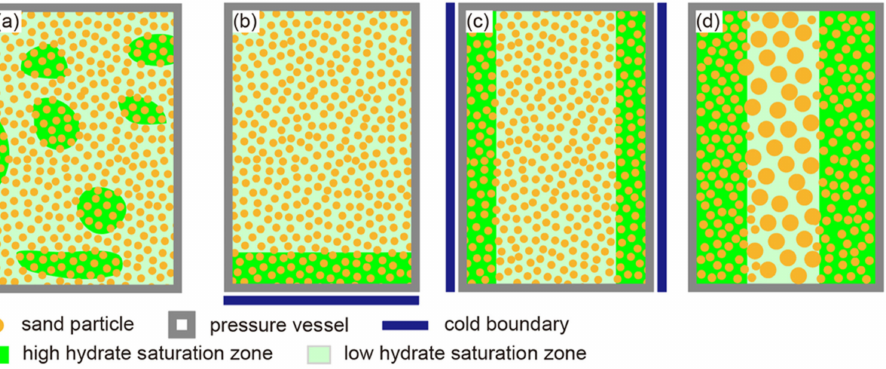
Figure 43. Several potential cases of heterogeneous hydrate distribution during upscaling process reprinted from [39] with permission from Elsevier. ( a ) Typical patchy distribution; ( b , c ) heterogeneous hydrate distribution due to water migration towards the cold boundary during hydrate formation; ( d ) heterogeneous hydrate distribution in layered systems.